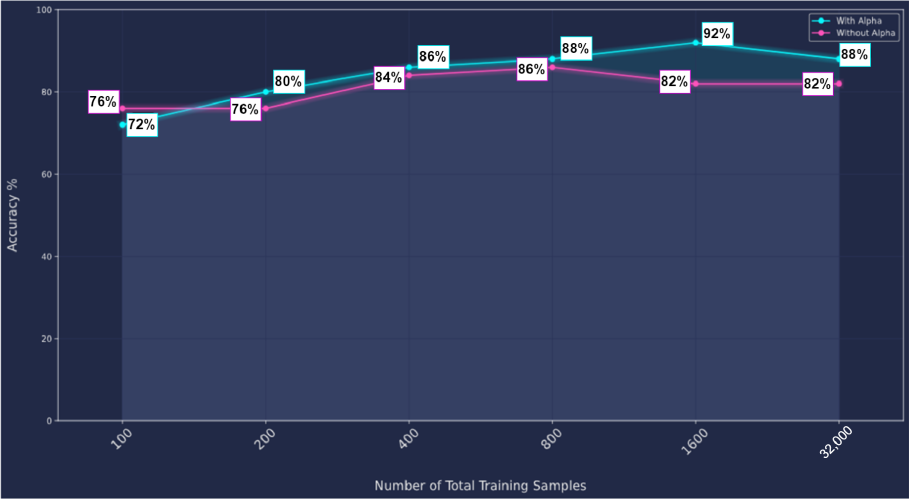
Figure 14. Augmentation by flipping: Original test dataset was kept the same. On the other hand, the training dataset was augmented from 100 graphs up to 32,000 graphs through 5